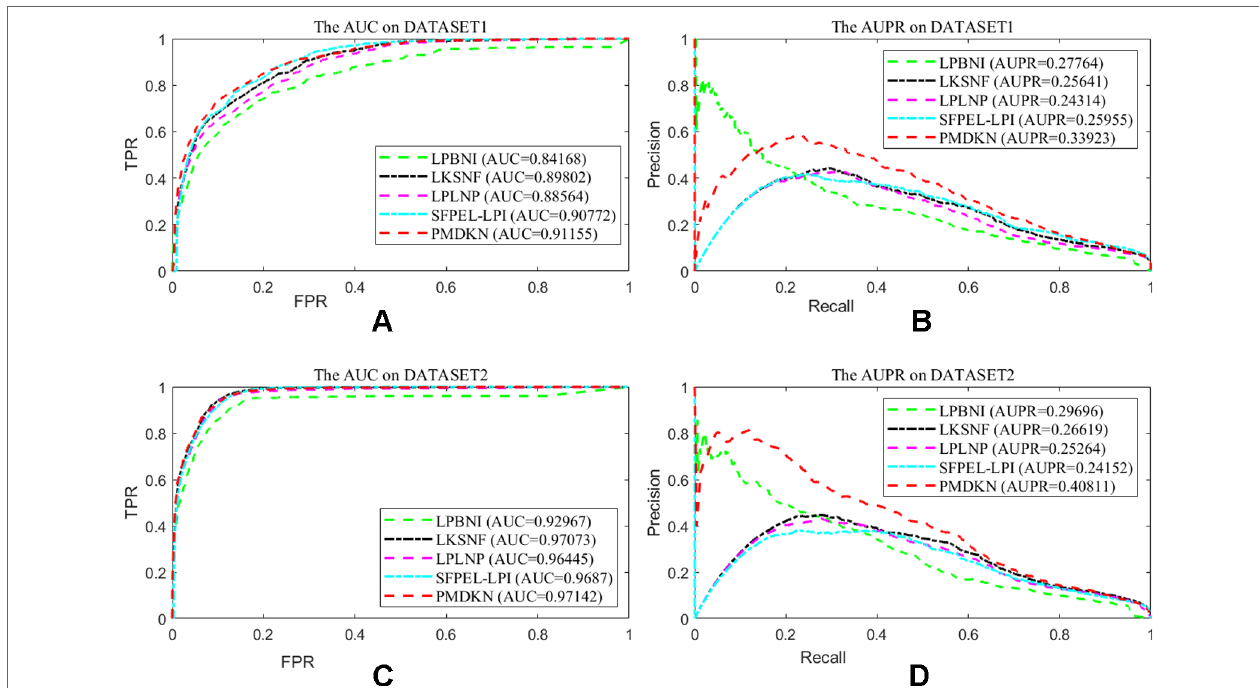
FIGURe 3 | Prediction performance of the model on disturbed data set. Among them, (A) shows the ROC curve and AUC value of the five methods after DATASET1 adds noise. (B) shows the P-R curve and AUPR values of the five methods after DATASET1 is added with noise. (C) shows the ROC curve and AUC value of the five methods after DATASET2 adds noise. (D) indicates the P-R curve and AUPR value of the five methods after DATASET2 is added with